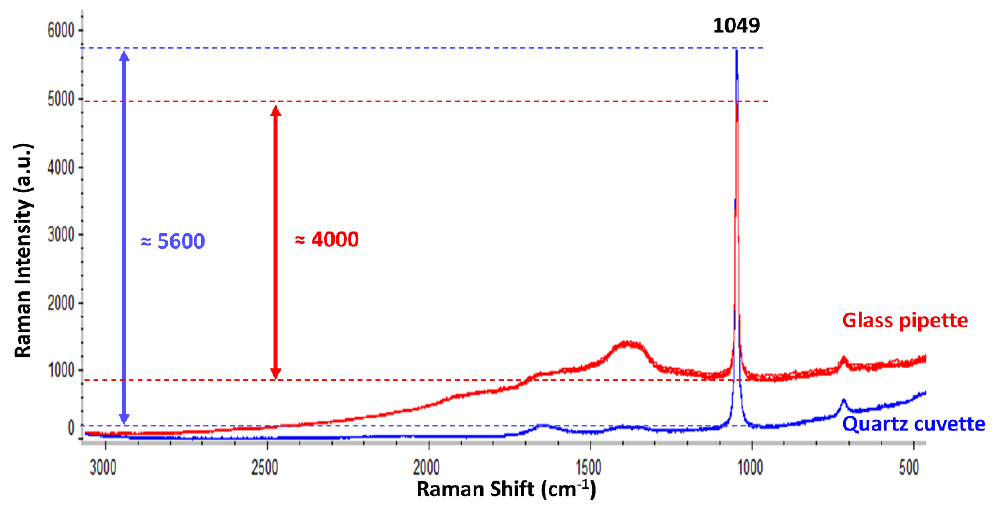
Figure 2. Five replicate Raman spectra for the 1M nitrate solution using either the quartz cuvette (blue) or the glass pipette (red) as flowing cells. All spectra are displayed using the same scale and no vertical offset.